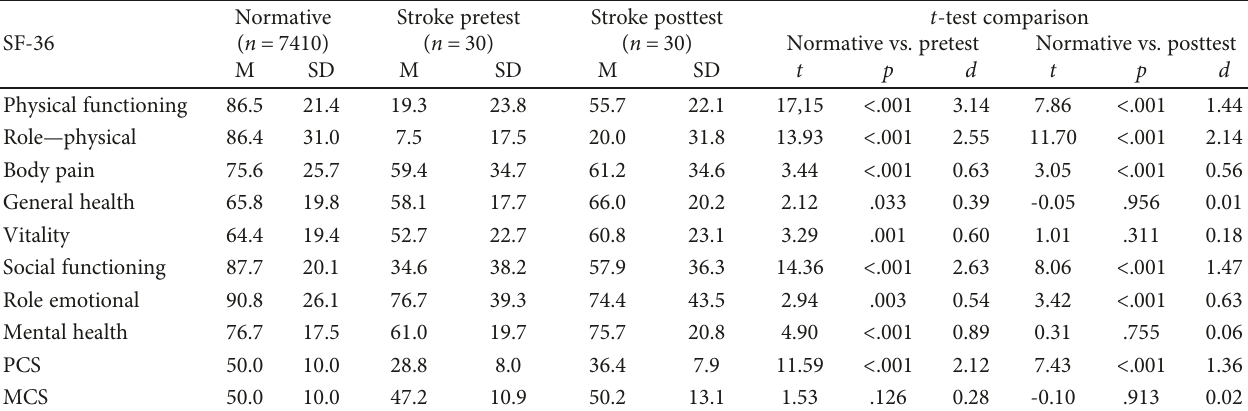
Table 4: Comparison between stroke group and normative group.